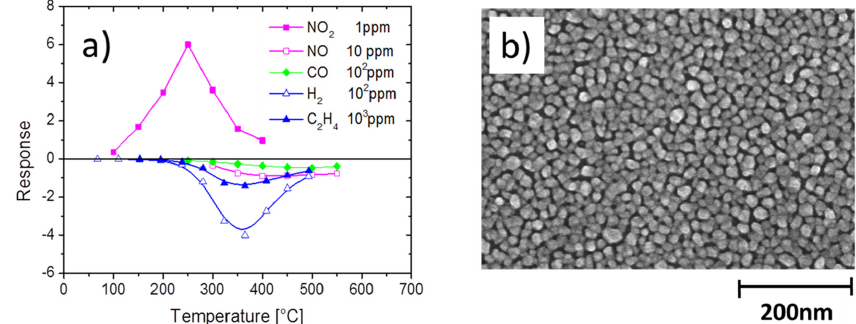
Figure 12. ( a ) Relative resistance change of a nano ‐ granular SnO 2 layer in response to oxidizing NO 2 and a range of reducing background gases. A dominating NO 2 response at low sensor operation conditions occurs due to the reactive nature of NO 2 and its thermal instability at higher temperatures (NO 2 → NO + ½ O 2 ); ( b ) nano ‐ morphology of the SnO 2 sensing layer.